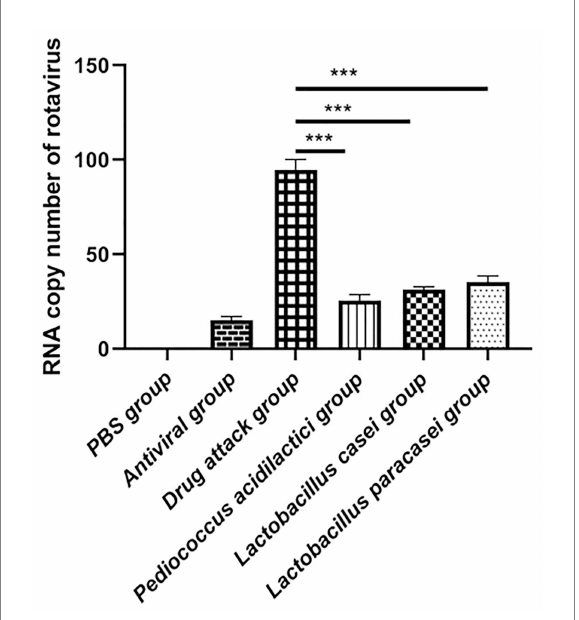
FIGURE 2 The number of virus copies was quantified in cultures of lactic acid bacteria and porcine intestinal epithelial